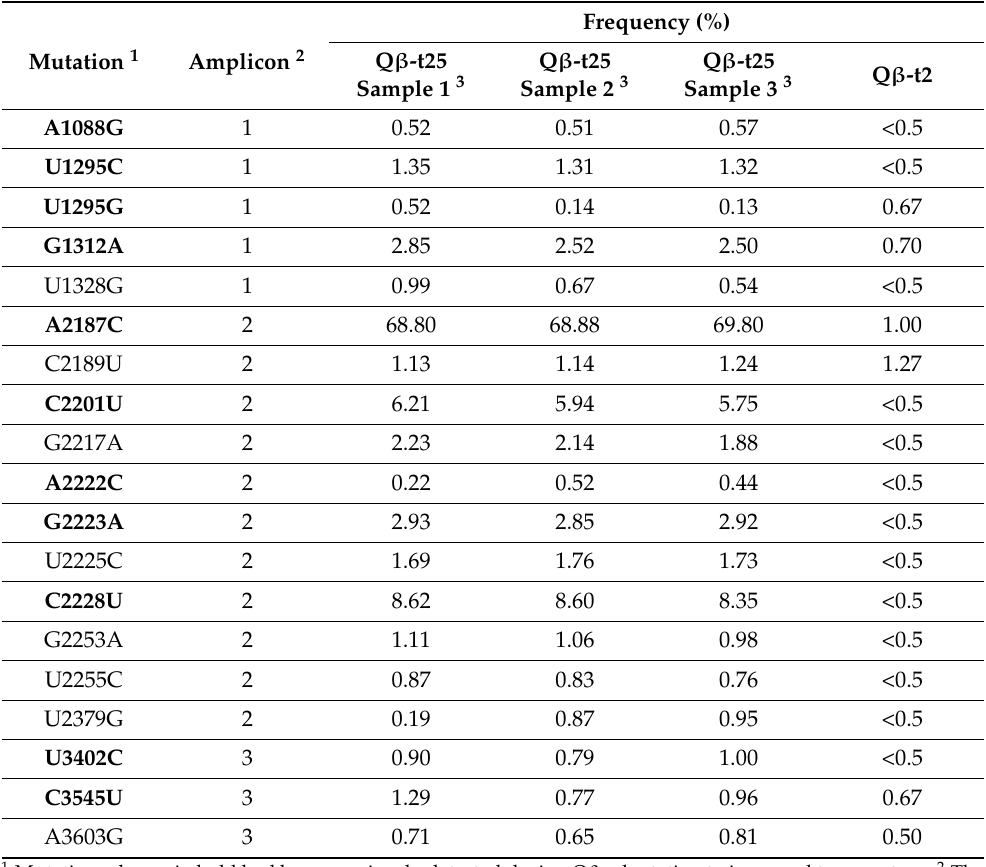
Table 2. Mutations represented above 0.5% in the deep sequencing analysis carried out with popula- tions Q β -t25 and Q β